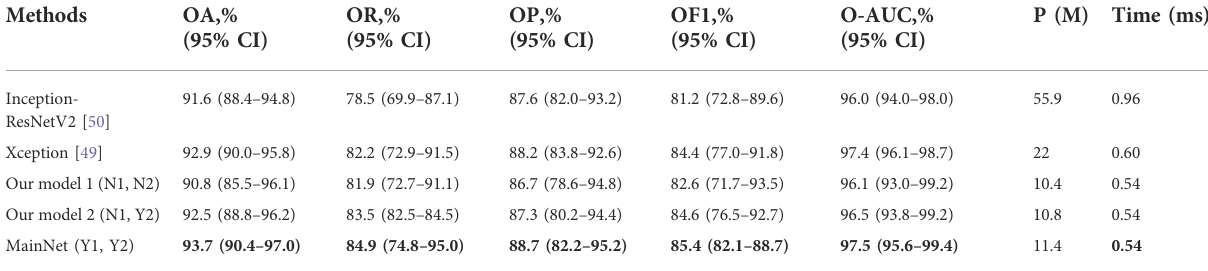
TABLE 2 Statistical comparison of ablation